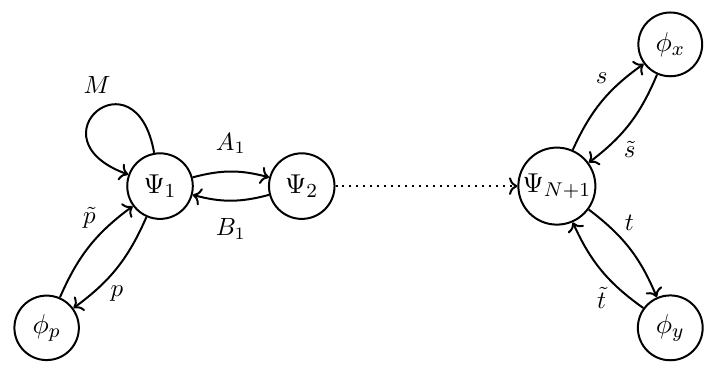
Figure 26 . Effective quiver for deformed D N +4